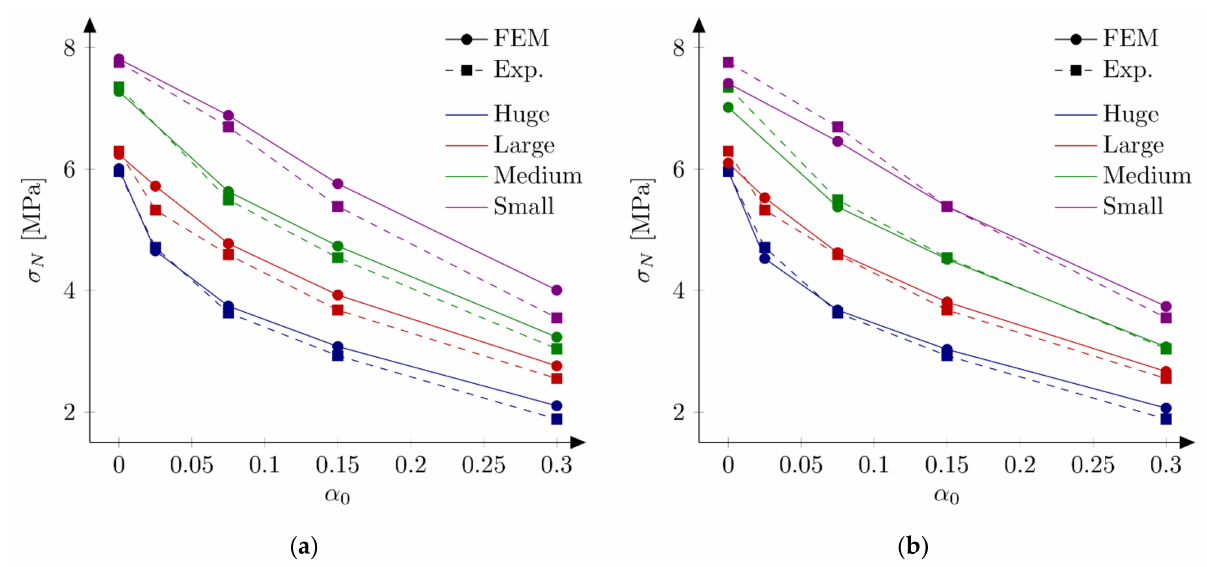
Figure 12. Nominal and experimental strengths with exponential softening law and: ( a ) set S10: